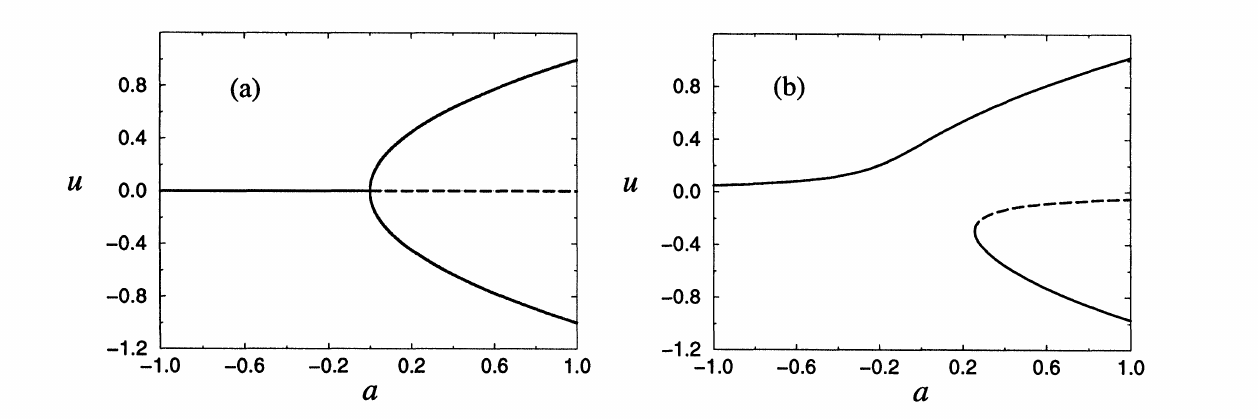
FIGURE 2 A pitchfork bifurcation diagram showing stationary solutions of Eq. (1) as functions of the control parameter a. (a) The symmetric case, b--0. (b) The asymmetric or imperfect case, b